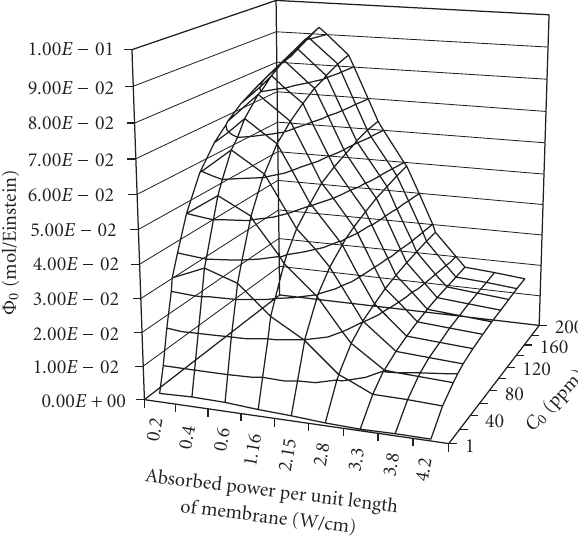
Figure 9: Quantum yields Φ 0 (mol of ethanoic acid/Einstein) as a function of initial concentration C 0 expressed as ppm (mass/vol ume) of carbon and of absorbed power per unit length of lamp (and membrane) expressed as Wcm − 1